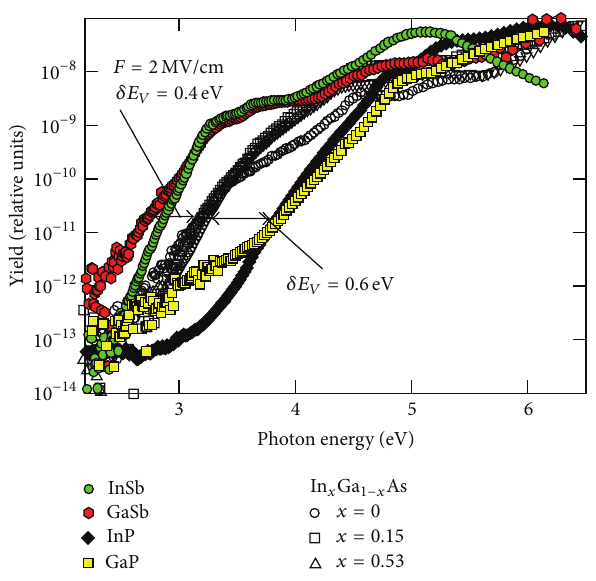
Figure 34: Comparison of the yield spectra for (100) faces of GaSb, GaAs, GaP, In 𝑥 Ga 1−𝑥 As ( 𝑥 = 0.15 , 0.53) InSb, and InP in contact with a 10–20 nm thick a-Al 2 O 3 insulating film measured under approximately equal strength of electric field in the oxide (positive bias applied to the opposite metal electrode). The inferred variations inthesemiconductorVBtopenergies( 𝛿𝐸 𝑉 )measuredrelativetothe common reference level of Al 2 O 3 CB edge are indicated by arrows.